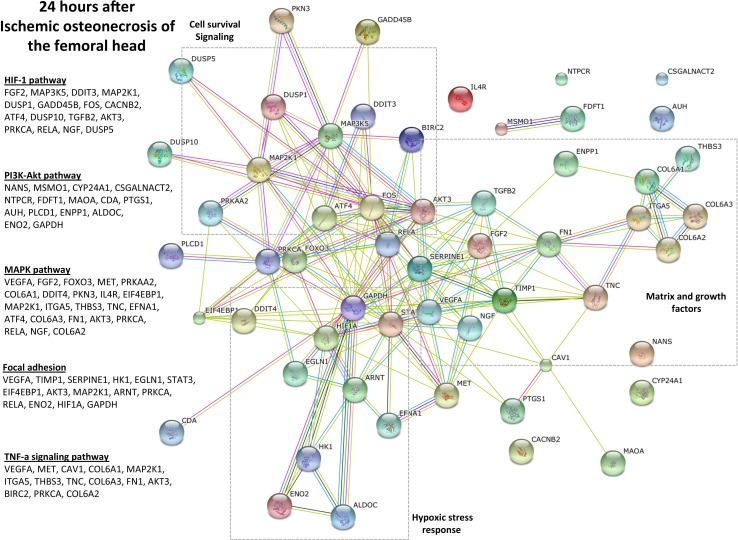
Response to hypoxic stress (HIF-1 pathway) and cell survival signaling pathways (PI3K-Akt, MAPK pathways) are the most significantly enriched functions in the immature articular cartilage at 24 hours following the induction of ONFH.The genes and the specific pathways that were significantly enriched (p<0.05, based on t-tests, Bonferroni, FDR) are listed. The network diagram (STRING10 software) indicates a close relationship of different genes based on the functional roles in biological pathways. The clusters of genes indicating specific biological functions (cell survival and signaling, matrix and growth factors, hypoxic stress response) are indicated using boxes with dashed lines. The nodes indicate individual genes and the connecting lines indicate the relationship. Shorter lines indicate closer relationship. This evidence plot utilizes multiple lines to indicate stronger evidence for the proximity in a functional relationship.